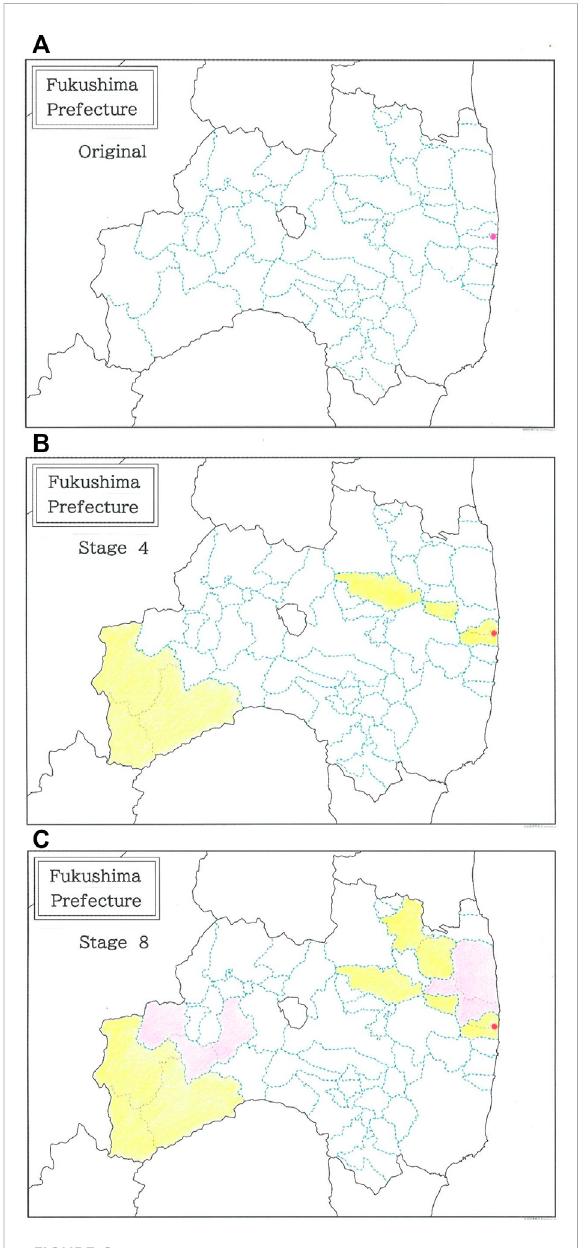
FIGURE 6 A complete map of Fukushima Prefecture. The pink dot on the east coast indicates the site of the Fukushima Daiichi nuclear power plant. (A) Before consolidation. (B) Under consolidations (Stage 4). (C) After consolidations (Stage